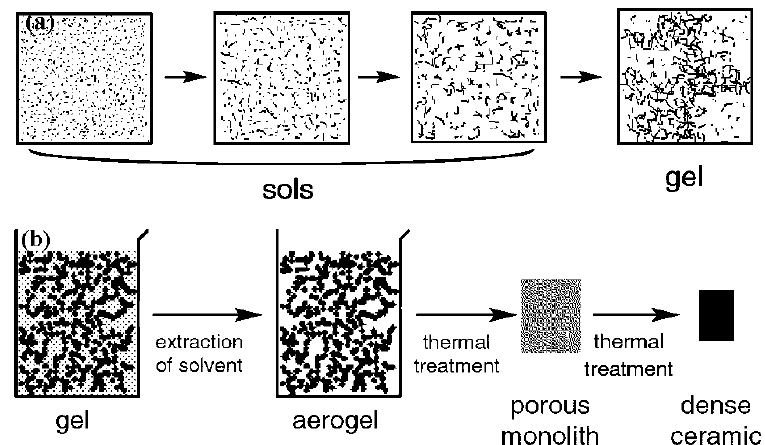
Figure 1. ( a ) The process of sol–gel transition. ( b ) Drying and calcining the gel to get molecular and nanostructured materials. Reprinted with permission from [18]. Copyright 2018, American Chemical Society.